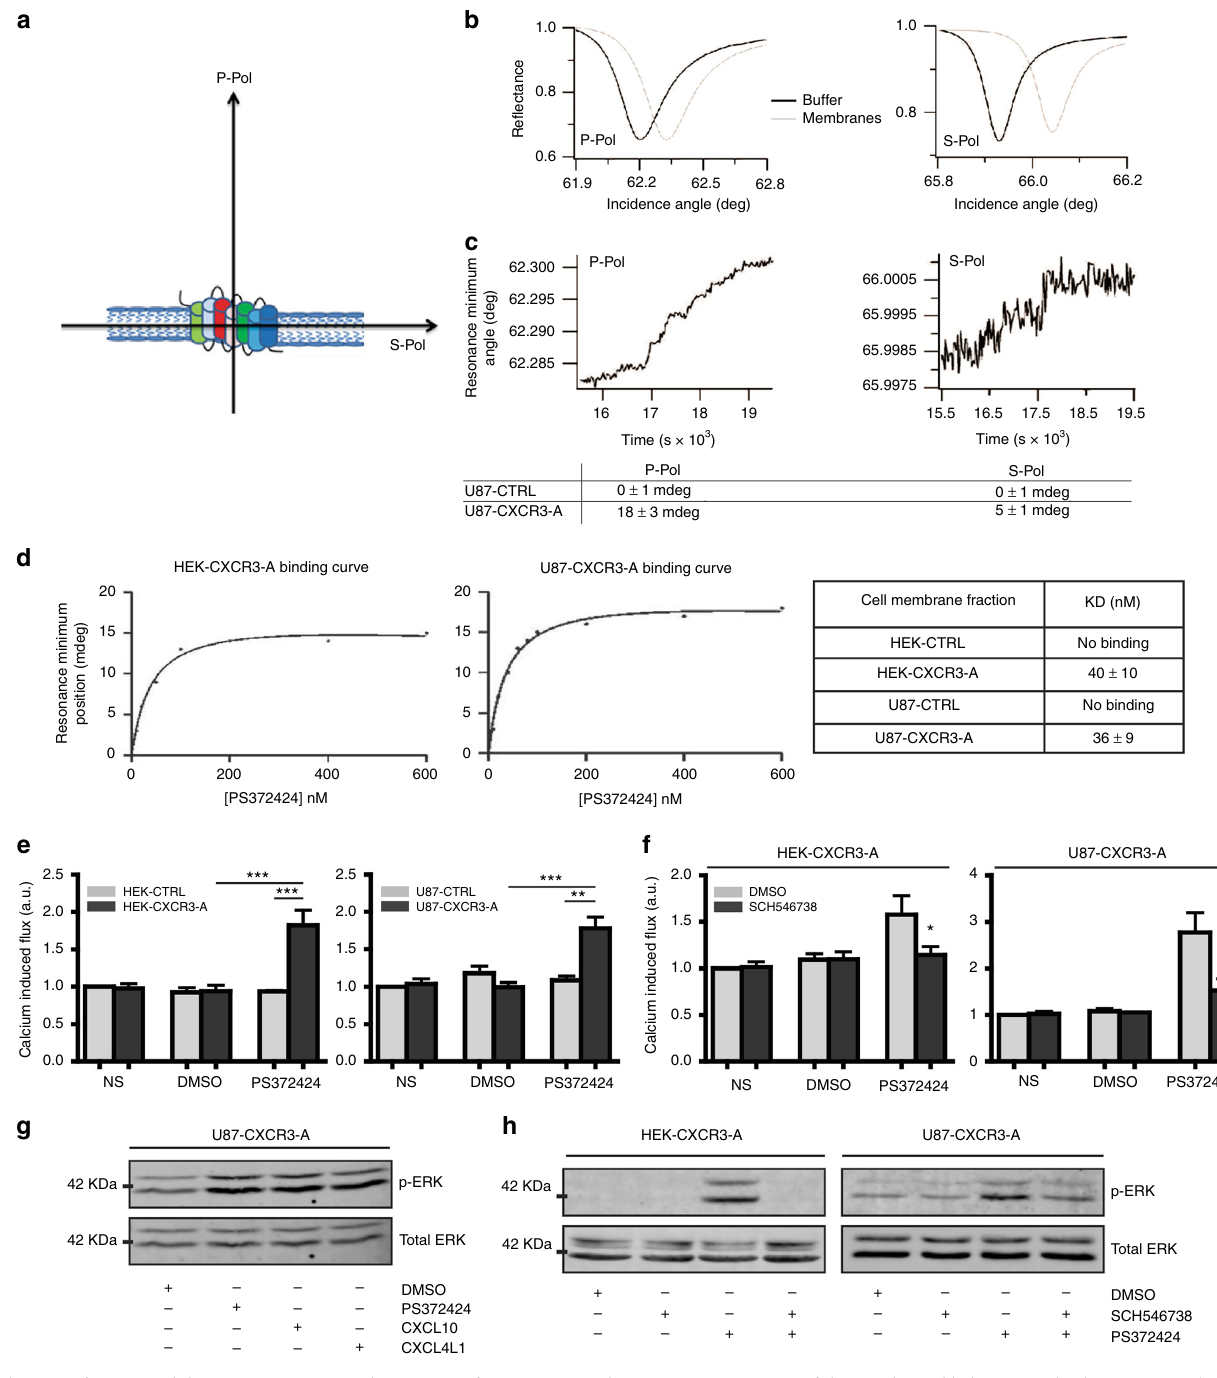
Fig. 2 Conformational dynamic properties and activation of CXCR3-A. a Schematic representation of the p -polarized light perpendicular to CXCR3 (referred as P -Pol for elongation of the receptor in the plasma membrane) and of the s -polarized light parallel to CXCR3 (referred as S -Pol for spreading of the receptor along the plasma membrane). b PWR spectra for the PWR sensor before and after immobilization of the cell fragments obtained with p -(left panel) and s -(right panel) polarized light in U87-CXCR3-A cells. c Changes in the minimum resonance position following incremental addition of CXCR3 agonist PS372424 to U87-CXCR3-A cell fragments as a function of time obtained with p -(left panel) and s -(right panel) polarized lights. d Binding curve and K D values for PS372424 interaction with CXCR3-A in HEK-CXCR3-A and U87-CXCR3-A. e Relative calcium-induced fl ux in HEK-CTRL/HEK-CXCR3-A cells (left panel) and in U87-CTRL/U87-CXCR3-A cells (right panel) after 20 s of CXCR3 agonist PS372424 stimulation. f Relative calcium fl ux in non-stimulated (NS) and stimulated HEK-CXCR3-A cells (left panel) and U87-CXCR3-A cells (right panel) when cells were pretreated or not with CXCR3 antagonist SCH546738. DMSO negative control, a.u. arbitrary unit. *** P < 0.001, ** P < 0.01, * P < 0.05. g CXCR3 activation assessed by measuring the phosphorylation level of ERK1/2 after 5 min of stimulation (100 ng/ml of CXCR3 agonists: PS372424, CXCL10, or CXCL4L1). h Activation of MAPK/ERK pathways after CXCR3 stimulation when cells were pretreated or not with CXCR3 antagonist SCH546738. Total ERK was used as loading control. All the results represent three independent experiments combined to calculate mean and SEM. Values were normalized to those obtained for the control cells. Multiple comparisons were performed with one-way analysis of variance, followed by Bonferroni post hoc